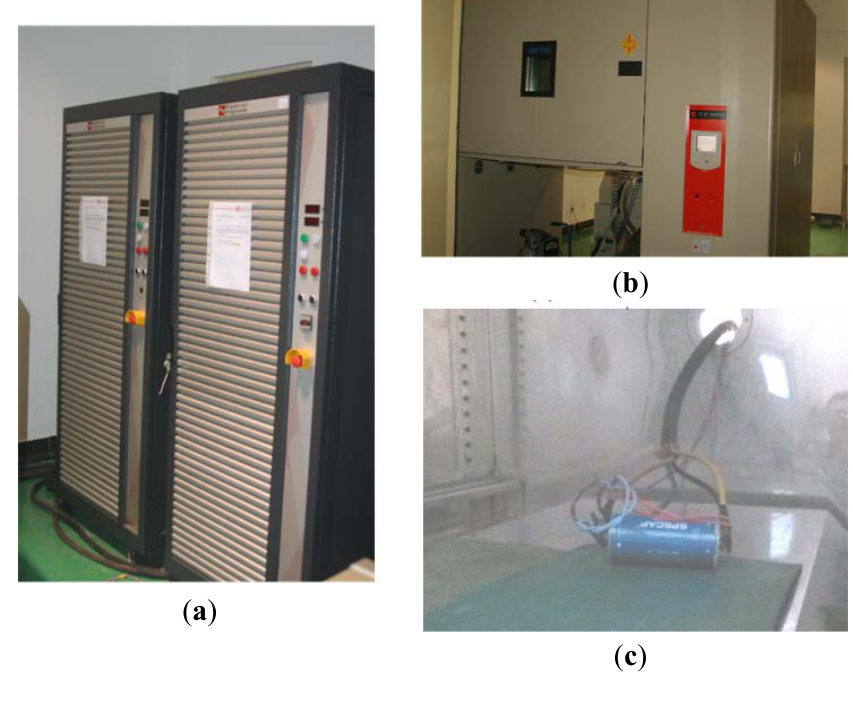
Figure 3. Pictures of the test rig. ( a ) The Digtron BTS-600, which is responsible